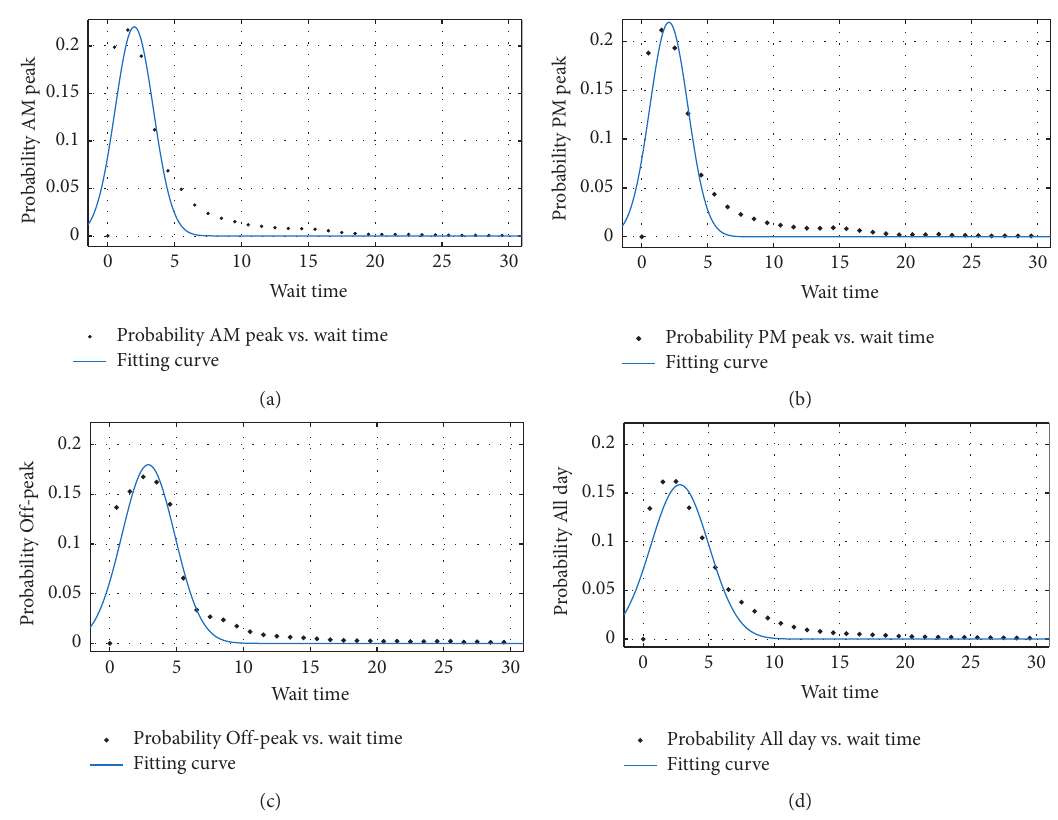
Figure 7: Probability distributions of wait time. (a) AM peak. (b) PM peak. (c) Off-peak. (d) All day.